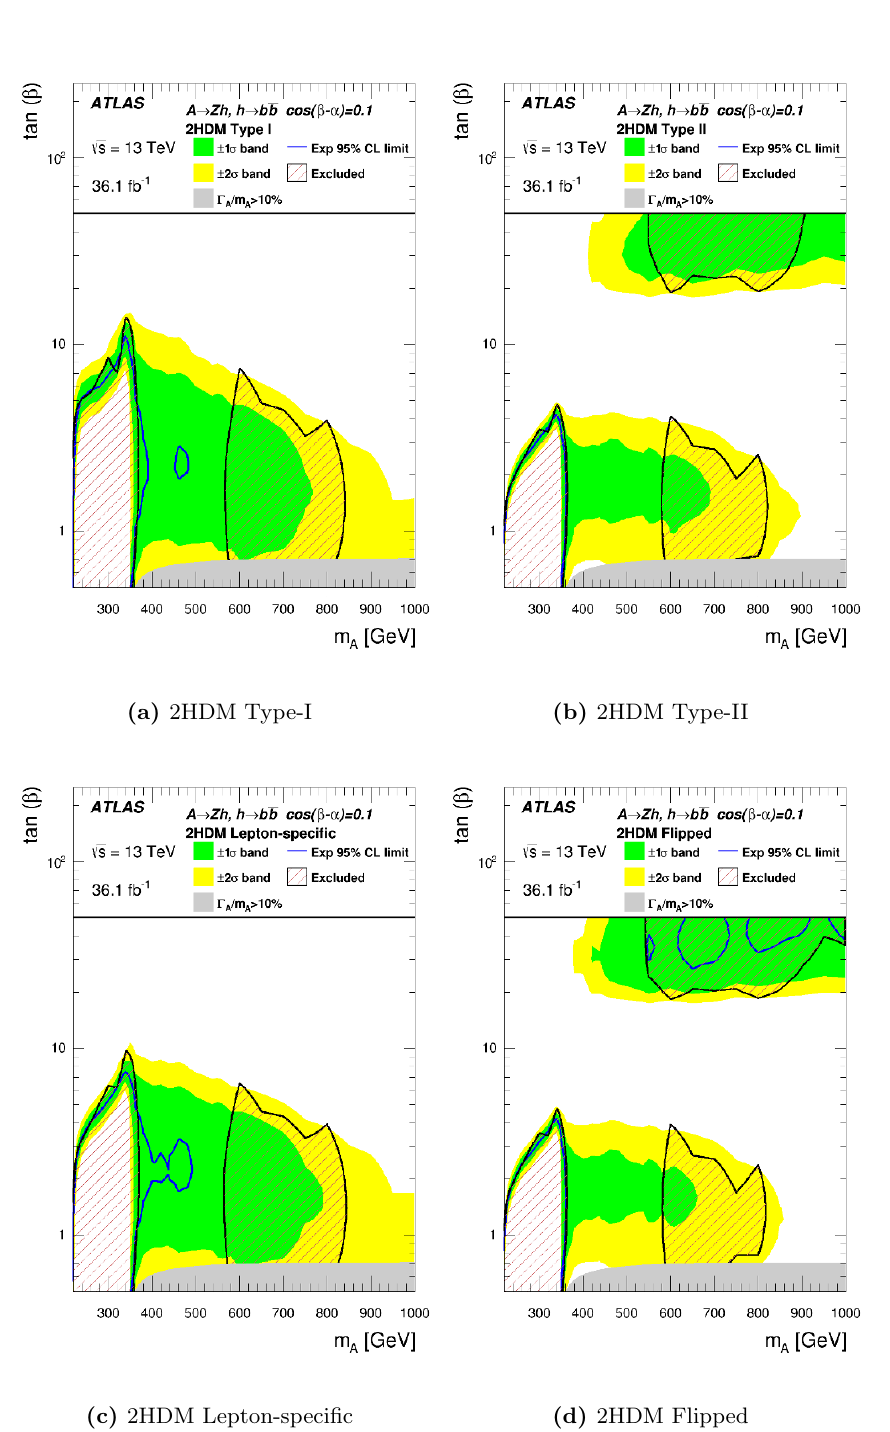
Figure 8. The interpretation of the cross-section limits in the context of 2HDMs of Type (a) I, (b) II, (c) Lepton-speci(cid:12)c, and (d) Flipped, as a function of the parameters tan( (cid:12) ) and m A for cos( (cid:12) (cid:0) (cid:11) ) = 0 : 1. Variations of the natural width up to (cid:0) A =m A = 10% have been taken into account.